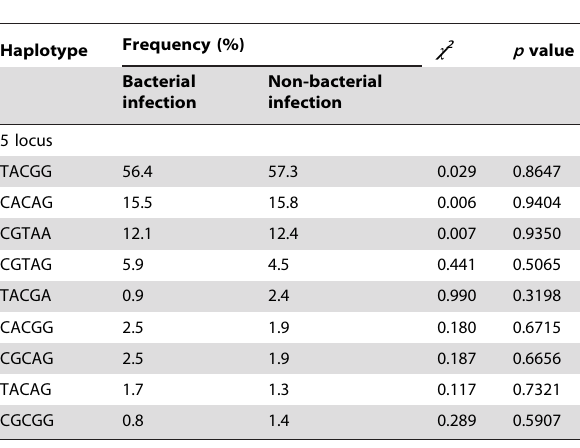
Table 7. The distribution of haplotypes in 5 locus of CTLA-4 between bacterial infection and non- bacterial infection. Table 8. The distribution of haplotypes in 5 locus of CTLA-4 between viral infection and non-viral